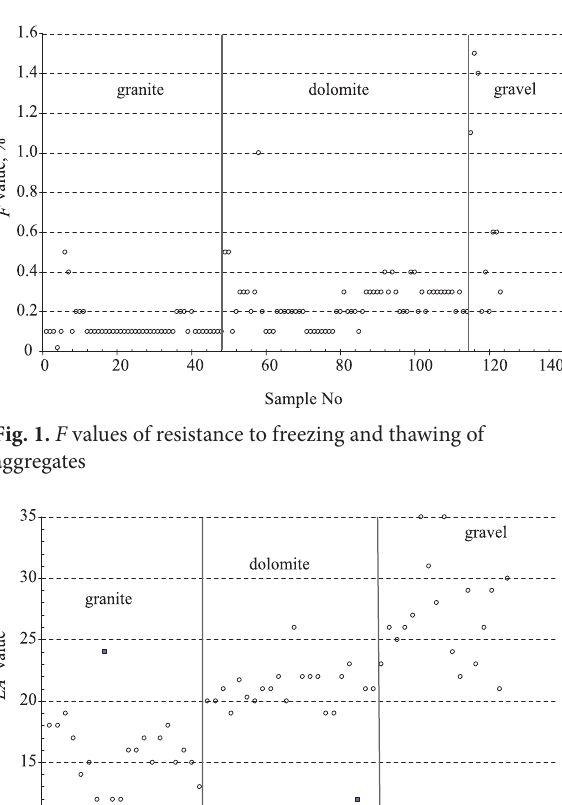
was made of 178 individual va- rd